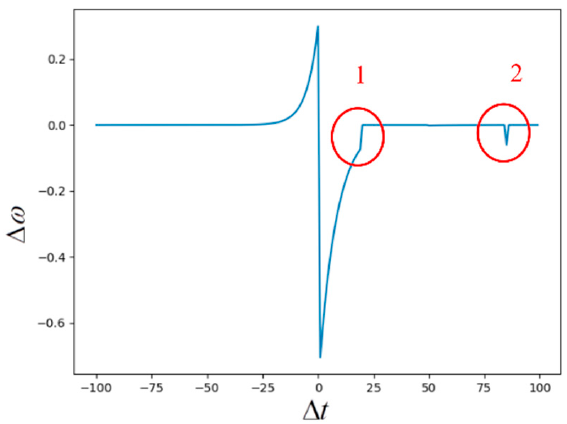
Figure 6. Graph of Lateral Inhibition.